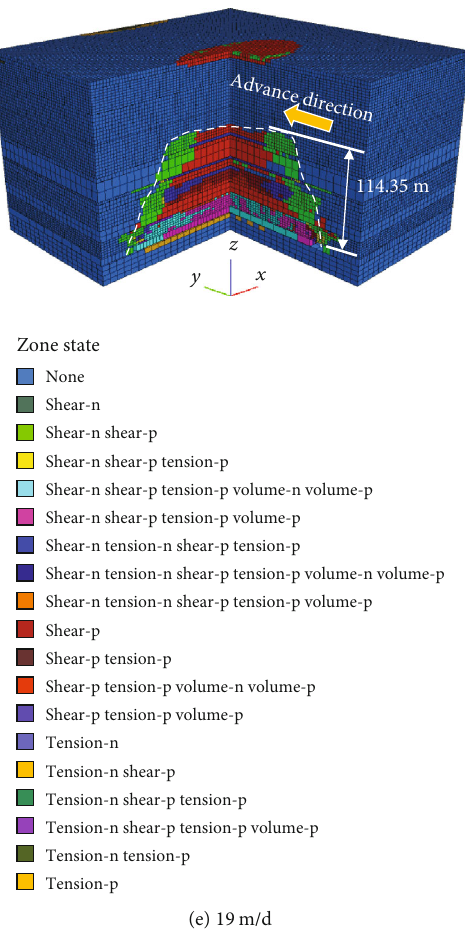
Figure 9: Distribution characteristics of plastic zones with di ff erent advancing